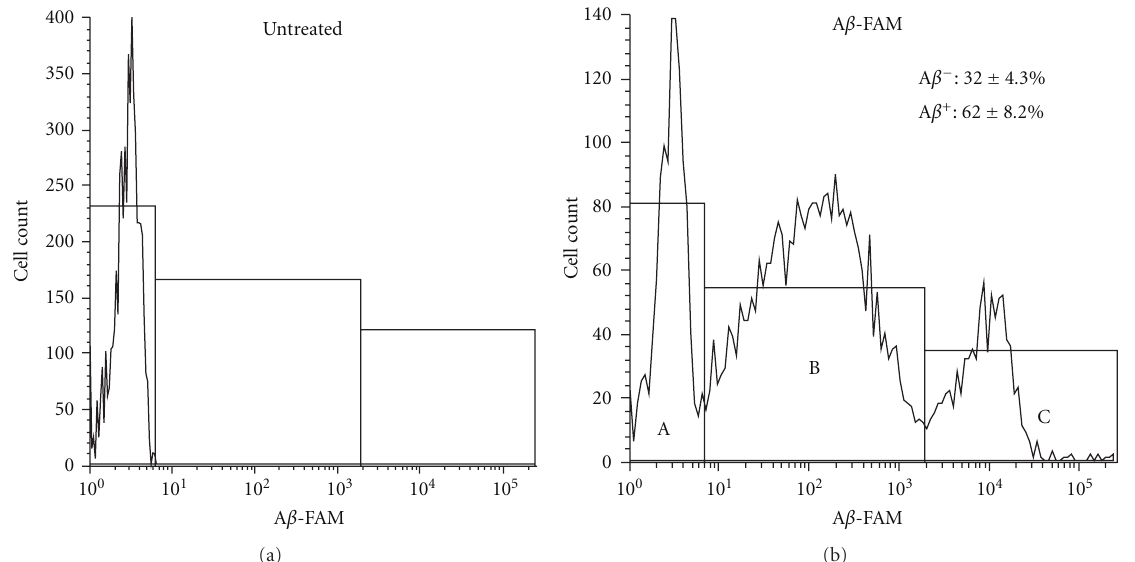
Figure 1: Fluorescence analysis of A β -FAM binding on PC12 cells. PC12 cells were exposed to A β -FAM for a short period of time (80min). Based on the levels of intensity of bound A β -FAM cells are grouped into three distinct subpopulations: a population of cells that did not bind A β (subpopulation A), a population of cells that show a high binding a ffi nity for A β (subpopulation B), and a population of cells that show an extra high binding a ffi nity for A β (subpopulation C). Fluorescence analysis showed that approximately 62% of all PC12 cells in the culture were classified as A β positive (A β +